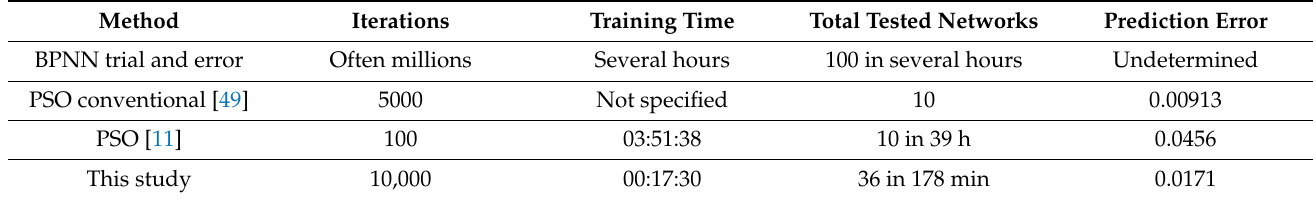
Table 11. Comparison of results with other